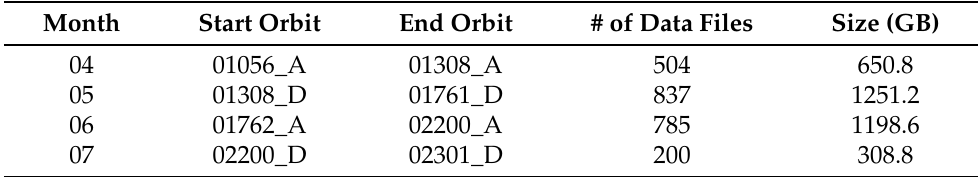
Table 1. SMAP L1-C high-resolution data summary (year: 2015; revision: R13080_001). Downloaded from Alaska Satellite Facility [49].